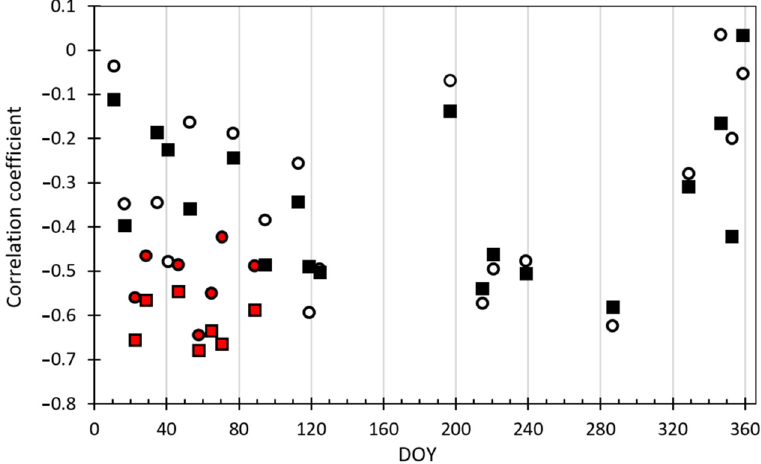
Figure 4. Correlation coefficients between AGB and the coherence of VH (circle) and VV (square) polarisation during the year. DOY, day of year. The coherence pair temporal baseline is 6 days combining S-1A and S-1B images. Red indicates the images used for the derivation of the average products. Correlations stronger than − 0.22 ( − 0.30) are significant at the 0.05 (0.01) level. In the case of the third group, Sentinel-2 DN values, the highest correlations with the AGB were observed for band B5 vegetation red edge (r B5 = − 0.85) and band B4 red (r B4 = − 0.76) from the top of the vegetation season (22 June 2017). In general, the red bands (B4 and B5) correlate higher than bands B8, near infrared (NIR), and B11, short-wave infrared (SWIR). For the analysed Sentinel-2 spectral bands, the relationship between the AGB and the DN values was negative. The exception is one significant positive case of B8 from the autumn season (Table